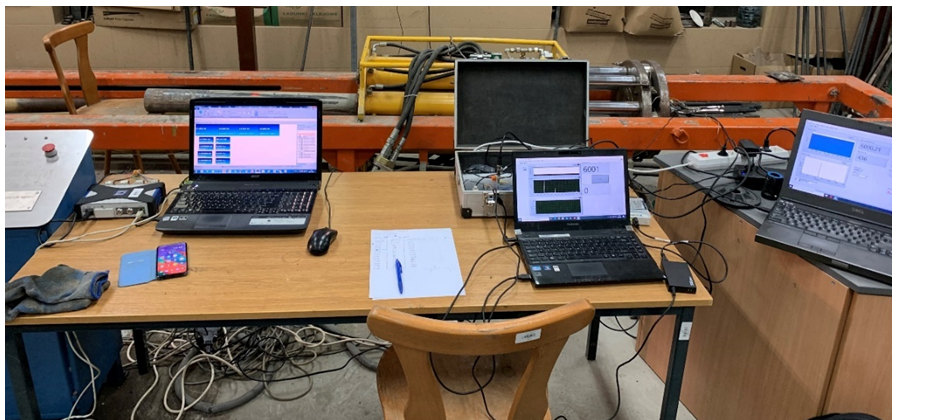
Figure 6. View of the measurement